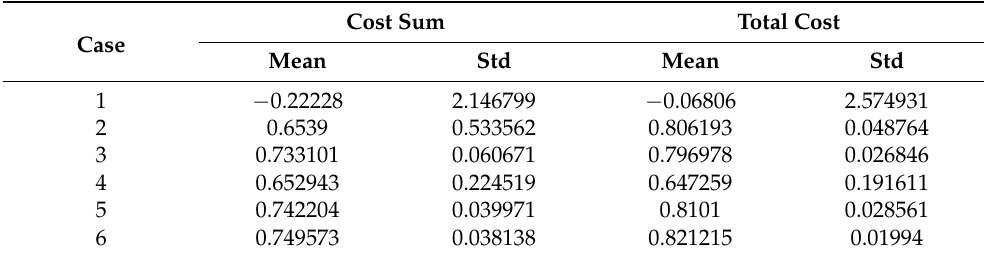
Table 5. Mean and Standard deviation of R-square.